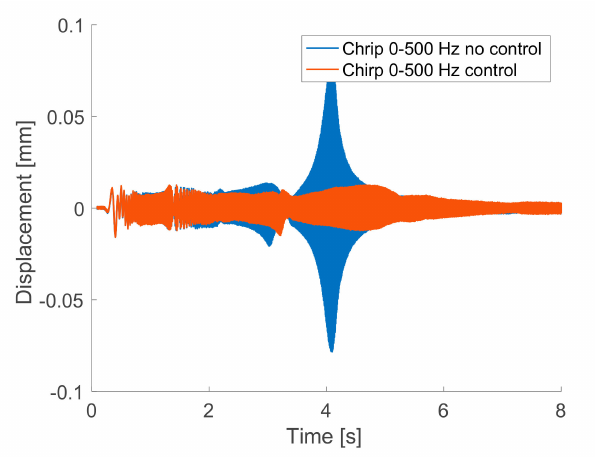
Figure 21. Experimental displacement in case of control on and o ff in case of multifrequency force applied.